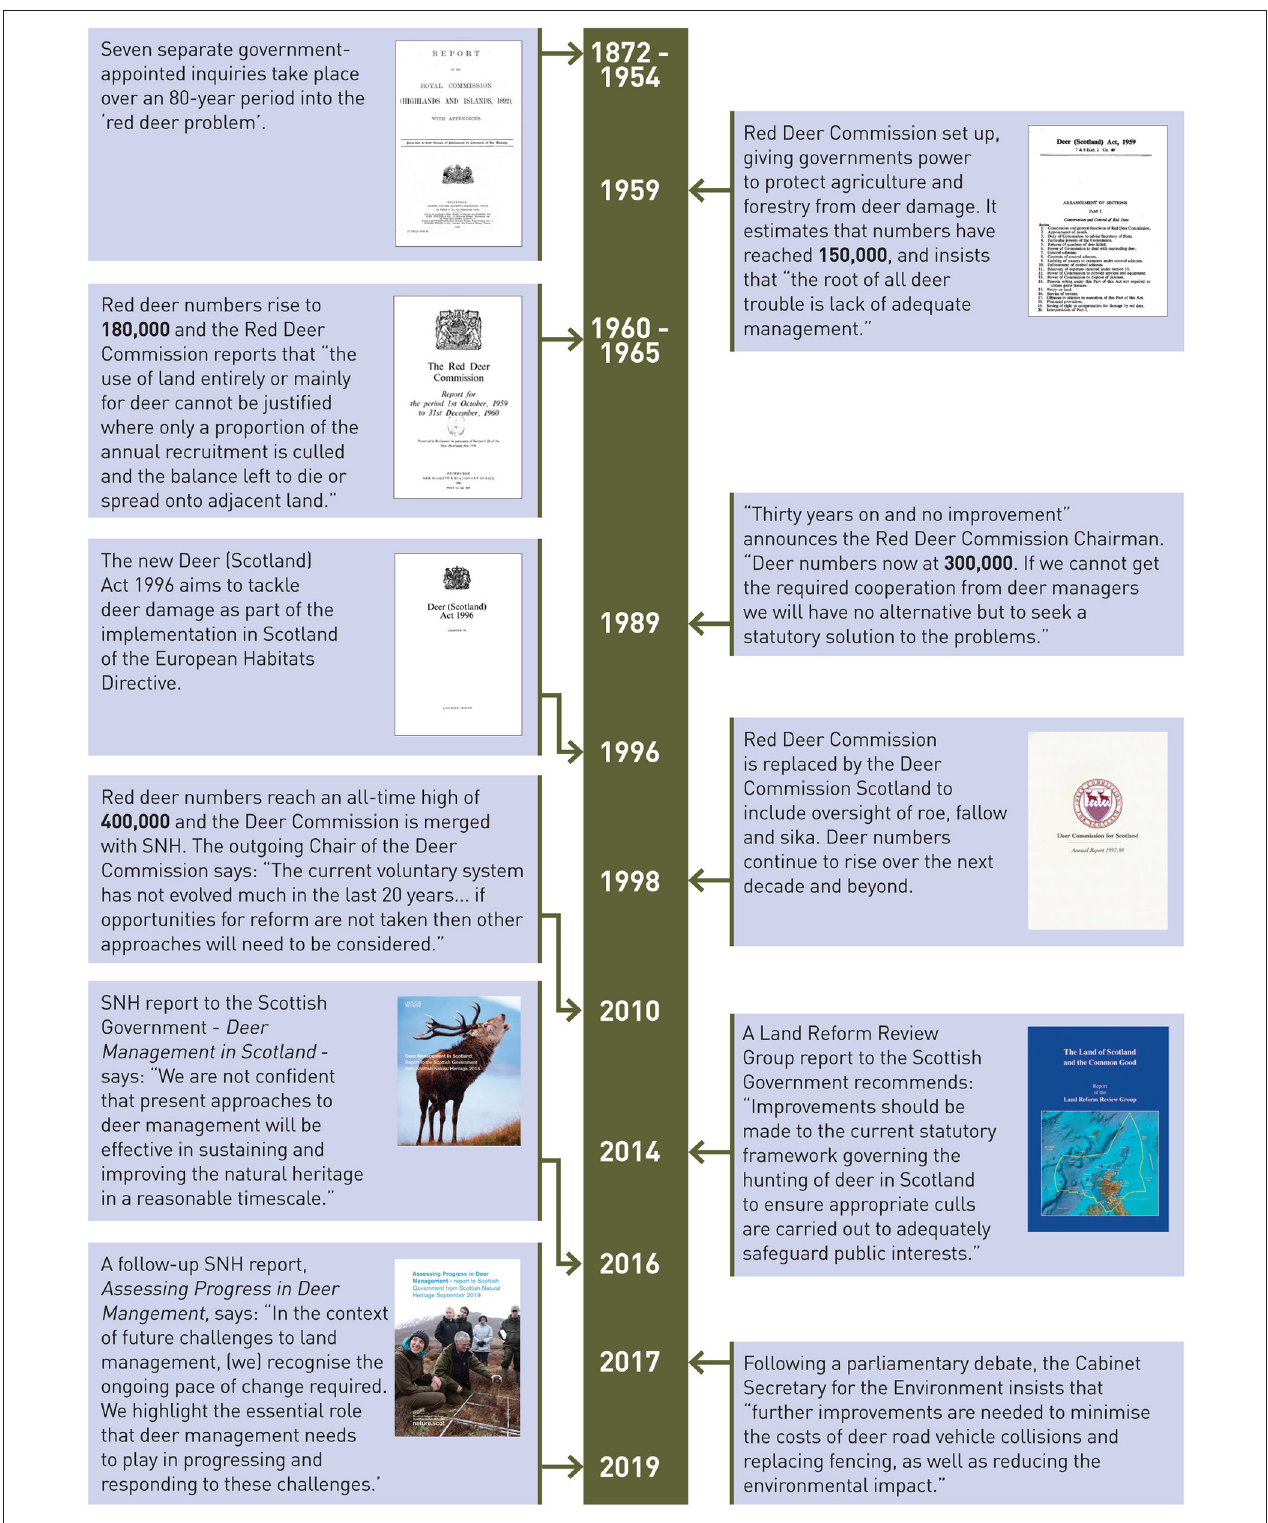
FIGURE 1 | Attempts to address persistent problems associated with deer in Scotland for approximately 150 years have achieved limited success. Reproduced with permission from Scottish Environment LINK (2020).